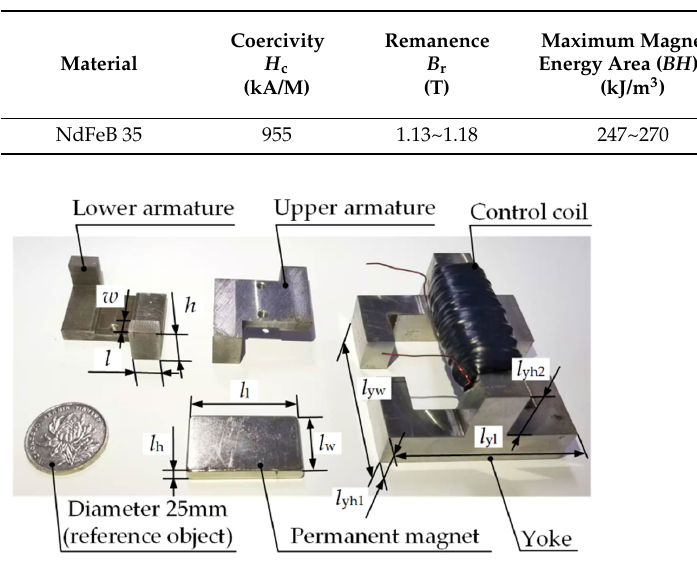
Table 6. Magnetic properties of NdFeB 35 [29].